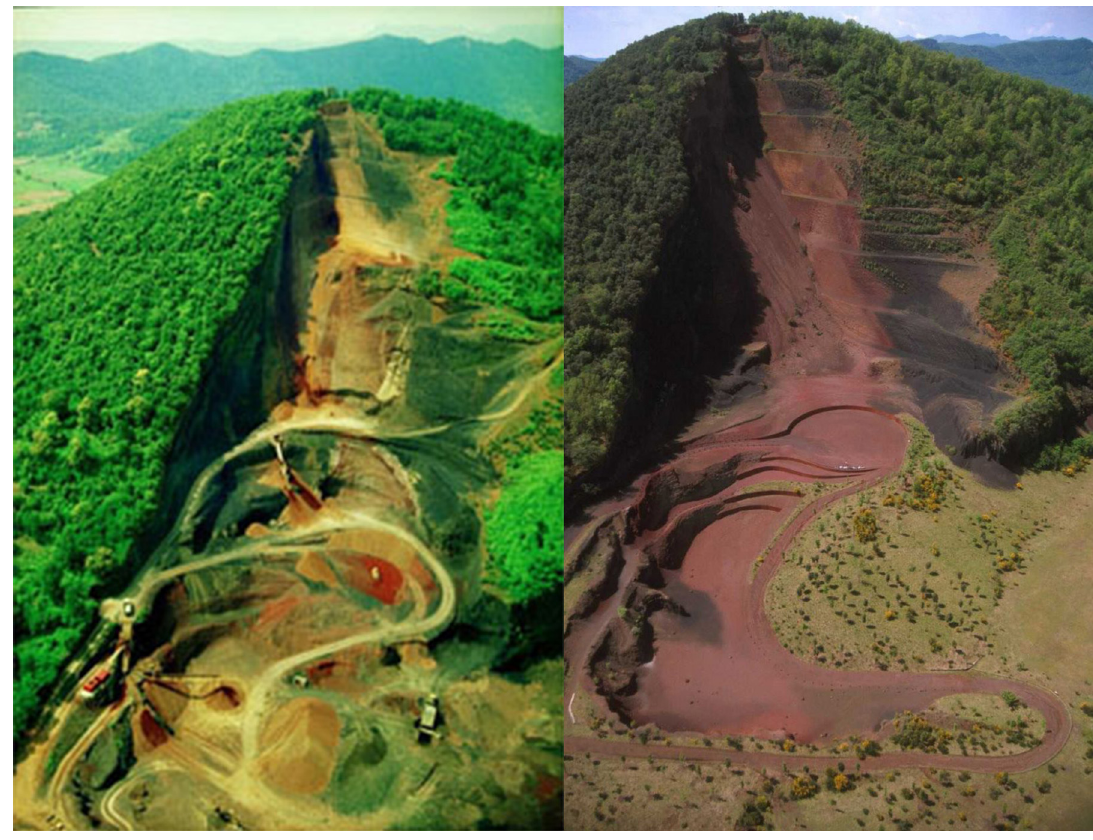
Figure 6: Croscat volcano, before and after preservationist intervention. Source: Parc Natural de la Zona Volcànica de la